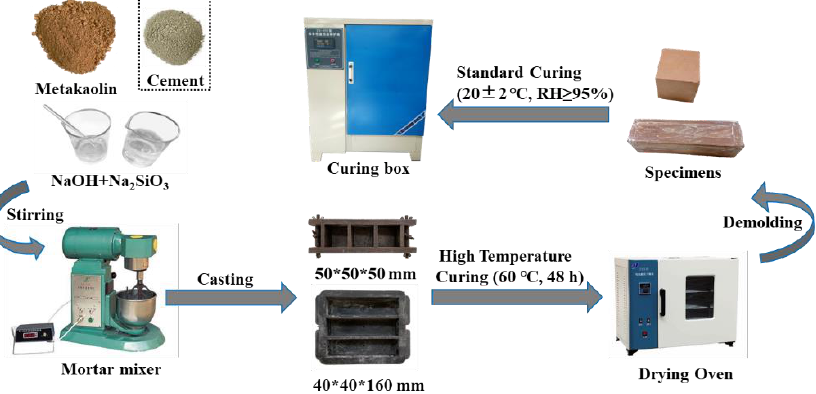
Figure 1. Preparation and curing process of geopolymers.